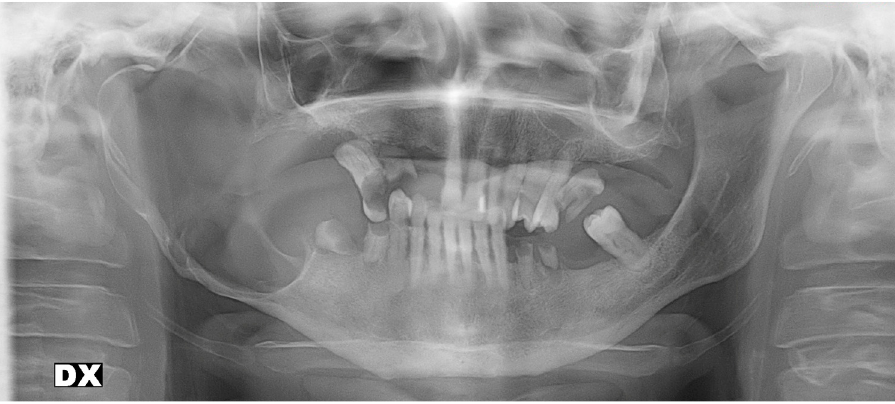
Figure 2. Pre-surgery panoramic X-ray showing a wide radiolucent lesion extending from dental elements 4.5 to the entire right mandible ramus involving the right mandibular body.